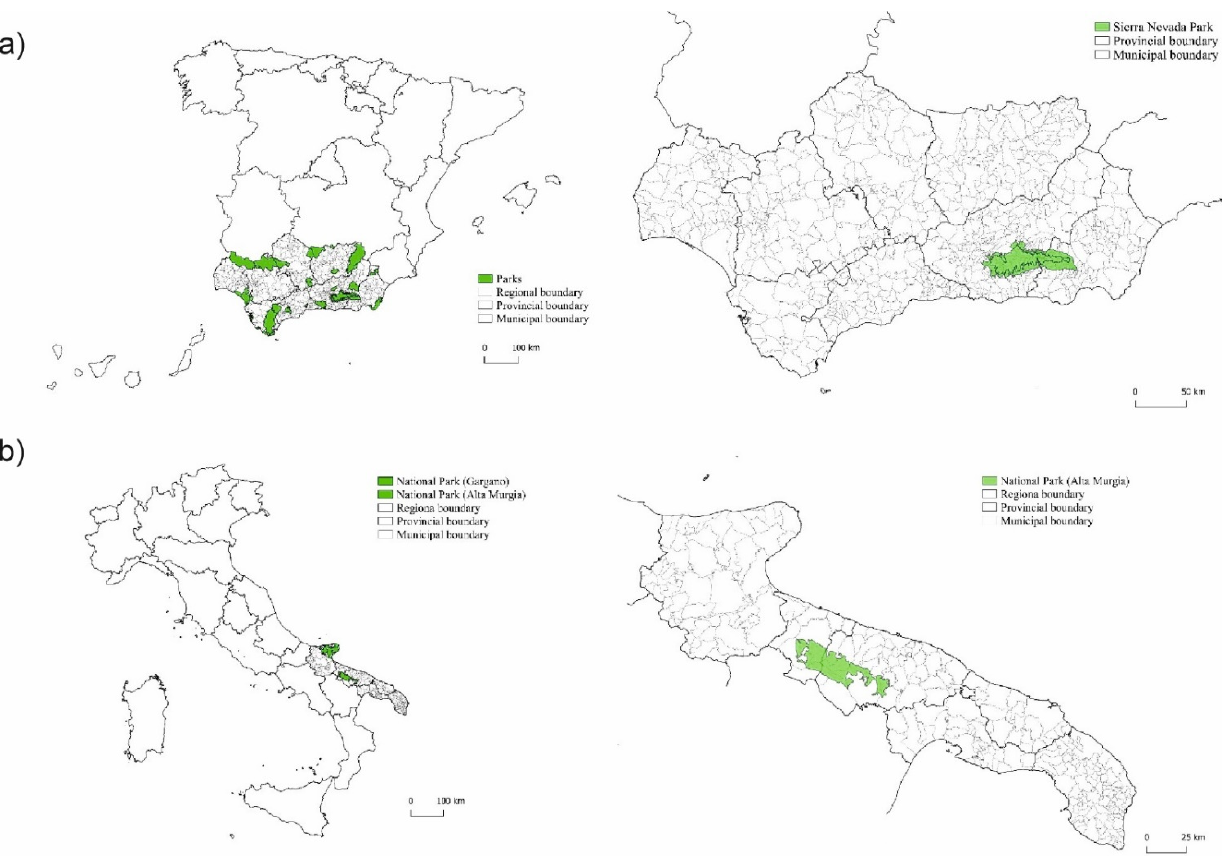
Figure 1. Location of ( a ) Sierra Nevada National Park within Spain and ( b ) the Alta Murgia National Park within Italy. Source: Map drawn by Labianca M.